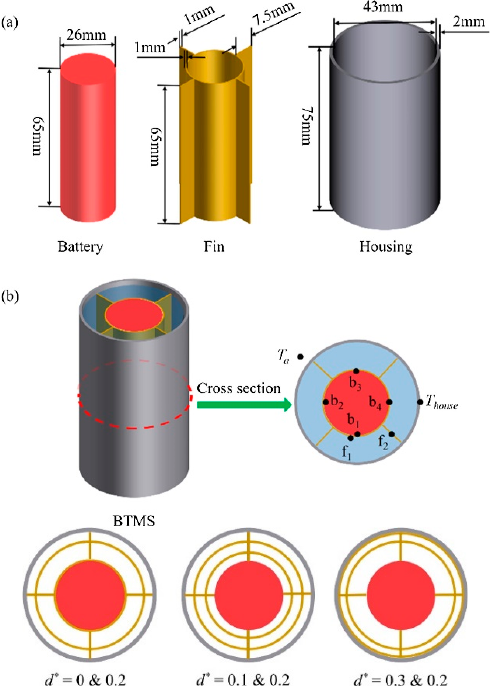
Figure 15. The combined shape fins proposed in [65]: ( a ) configuration of the BTMS with fins and PCM; ( b ) locations of the temperature measurement sensors. 𝑑 ∗ —dimensionless distance of the ring, defined as the ratio of the radial distance of the ring to that of the diameter of the battery. Reproduced with permission from Elsevier.